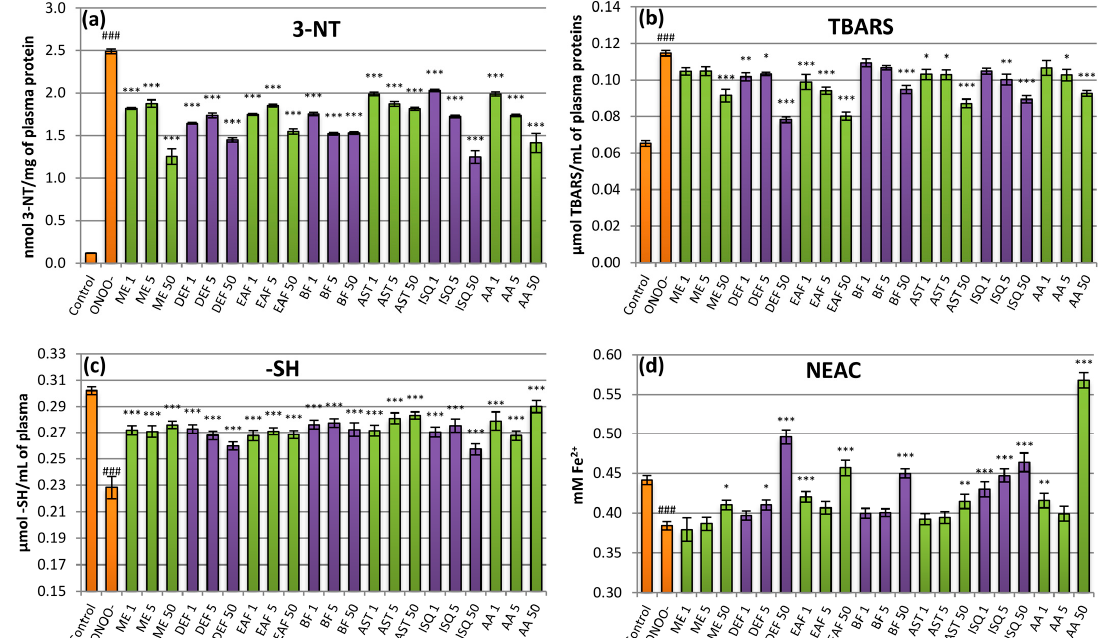
Figure 4. Effects of the investigated analytes on human plasma exposed to oxidative stress. ( a ) Effects on the nitration of plasma proteins assessed by the levels of 3-nirotyrosine (3-NT) and expressed as the 3-nitrotyrosine-containg equivalents (nmol of 3-NT-Fg/mg of plasma protein); ( b ) effects on lipid peroxidation assessed by the levels of thiobarbituric acid- reactive substances (TBARS); ( c ) effects on plasma protein thiol levels (-SH); ( d ) effects on the non-enzymatic antioxidant capacity (NEAC) of plasma, assessed by ferric reducing ability of plasma (FRAP). Results presented as means ± SE ( n = 12–14). Statistical differences: ### p < 0.001 for control plasma versus ONOO − -treated plasma (without the investigated analytes); * p < 0.05, ** p < 0.01, *** p < 0.001 for ONOO − -treated plasma in the presence of the analytes versus ONOO − - treated plasma without the analytes. Analytes: ME—methanol extract; DEF—diethyl ether fraction; EAF—ethyl acetate fraction; BF— n -butanol fraction; AST—astragalin; ISQ—isoquercitrin; AA—ascorbic acid; number after analyte symbol indicates concentration in µ g/mL.